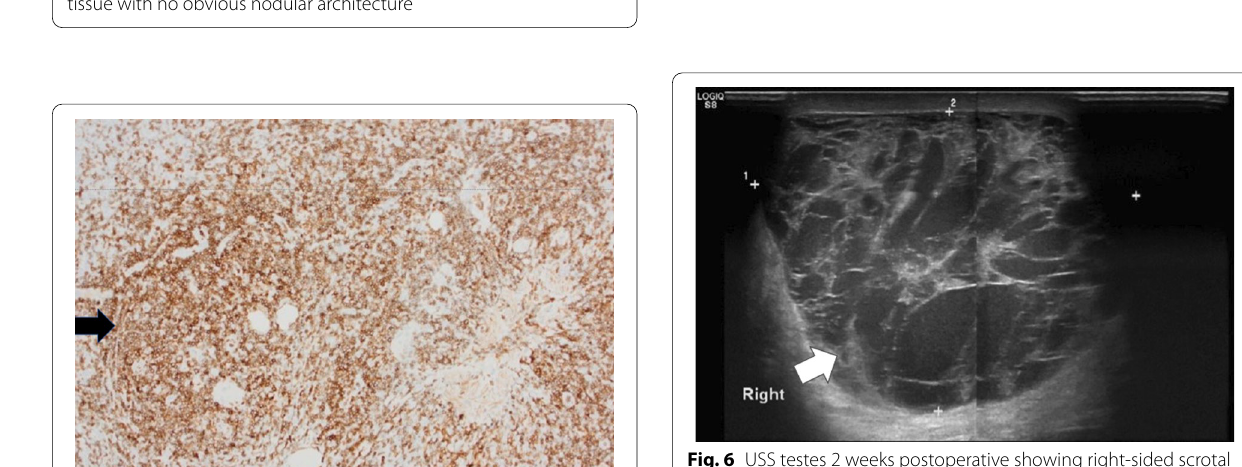
Fig. 5 Immuno‑histochemical staining negative for CD 23